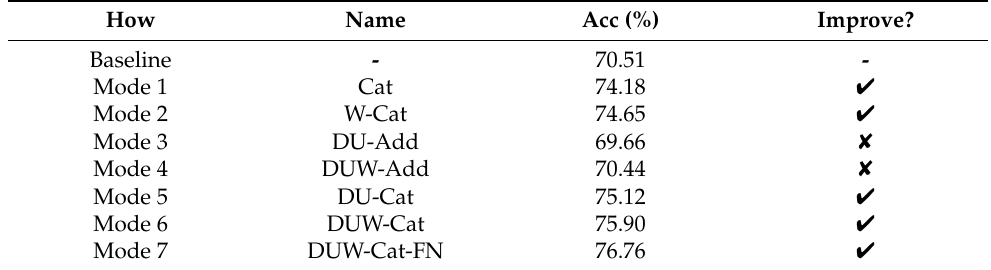
Table 12. Results of VGGNet + HOG with different injection modes on the OpenSARShip-1.0 dataset.